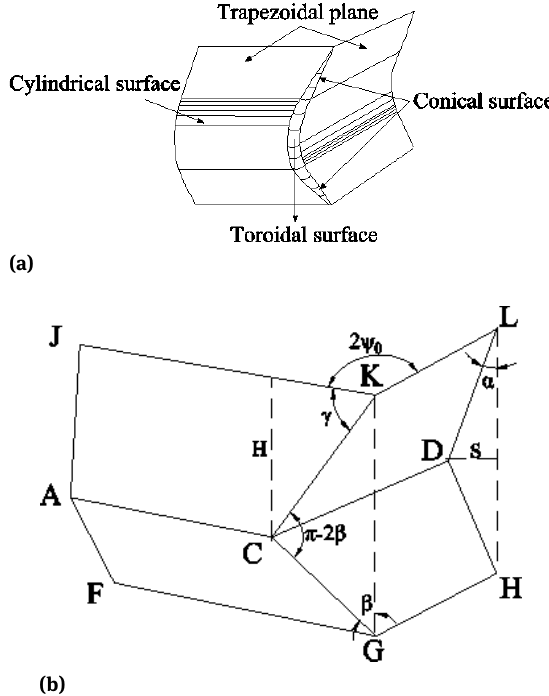
Figure 8: Folding model of an angle element: (a) basic folding element; (b) geometrical